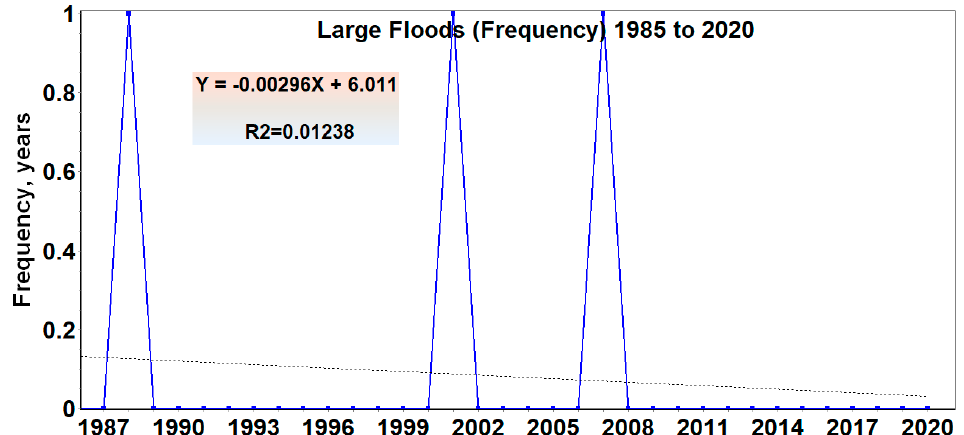
Figure 4. Extreme low flow, small flood, large flood frequencies (in days for extreme low flow and years for small and large floods).